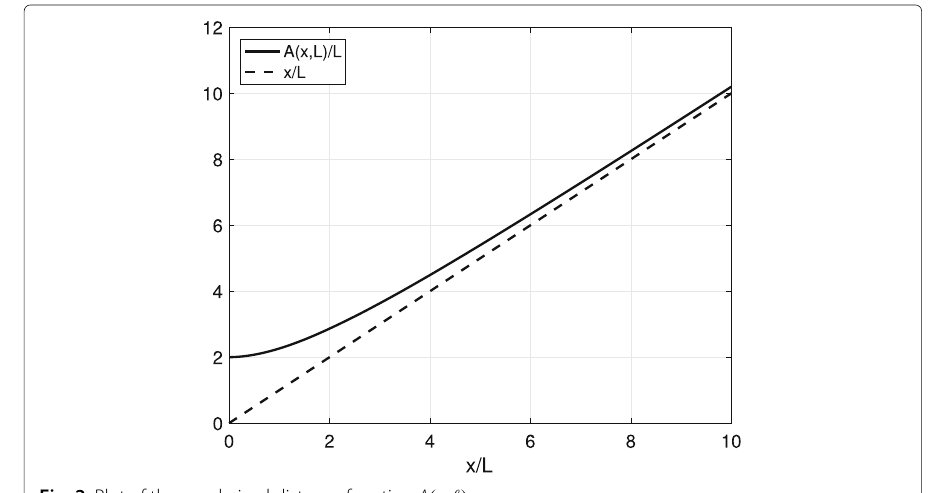
Fig. 2 Plot of the regularized distance function A ( x , (cid:13))